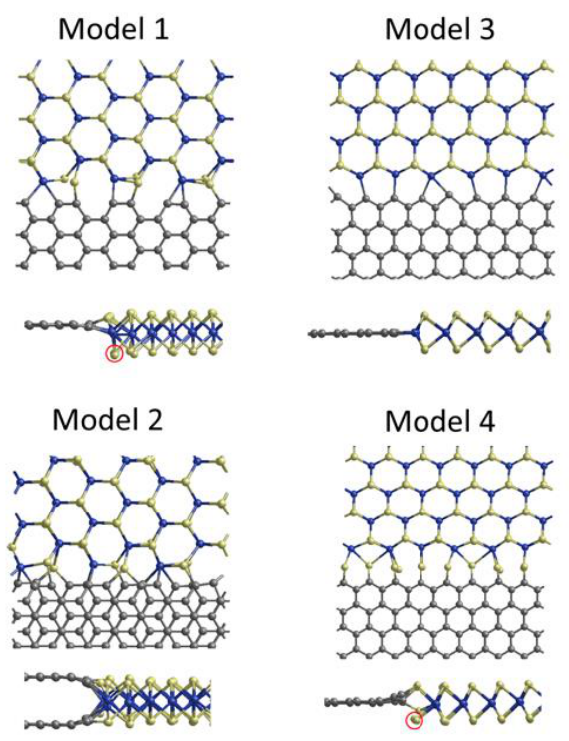
Figure 5. Top and side views of the relaxed atomic configurations of lateral graphene / MoS 2 interface models [59]. Model 1 and model 2 correspond to armchair edge contacts, with a single graphene layer and a double graphene layer, respectively. Models 3 and 4 correspond to zigzag edge contacts with Mo termination and S termination, respectively. Dark-gray, blue, and yellow spheres correspond to C, Mo, and S atoms, respectively. The S dangling bonds in model 1 and model 4 are encircled in red.